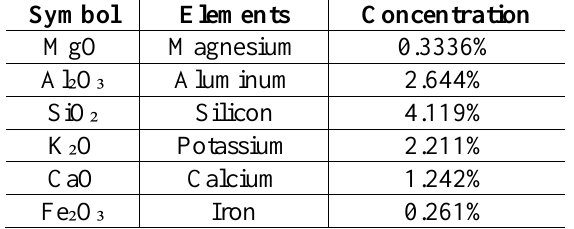
Table 1: The elements Concentration for Indian Costus